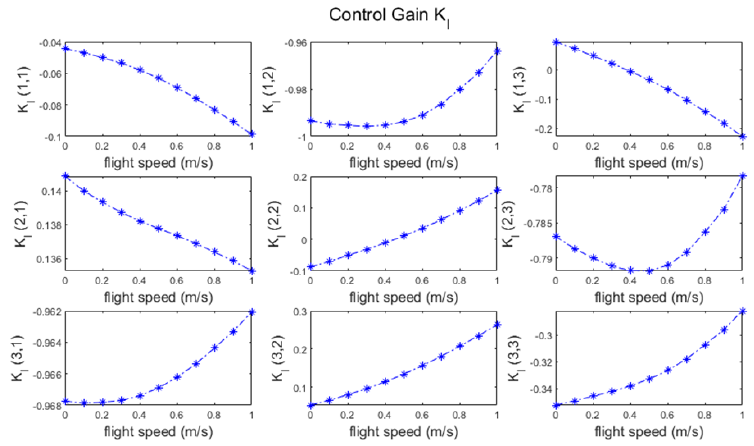
Figure 6. Gain matrix values for K S at different flight speeds.